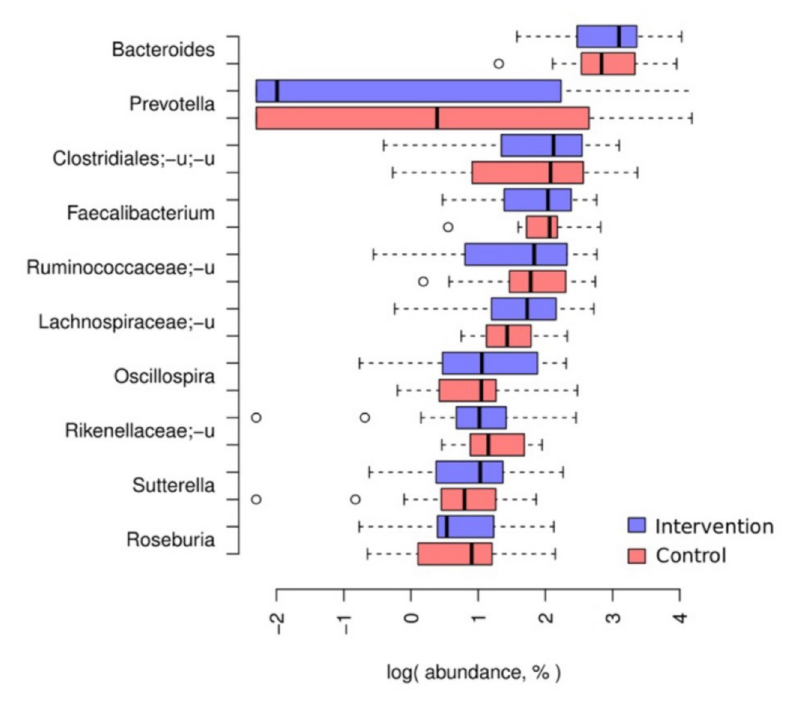
Figure 2. Major taxa. Boxplots detailing the distribution of relative abundance for the 10 most abun- dant genera; for appropriate display on a log scale, zero values were replaced with a pseudocount (0.1%). In addition, boxplots detailing the distribution of relative abundance for the 25 most abundant taxa in each taxonomic rank at baseline are available in the Supplementary Materials